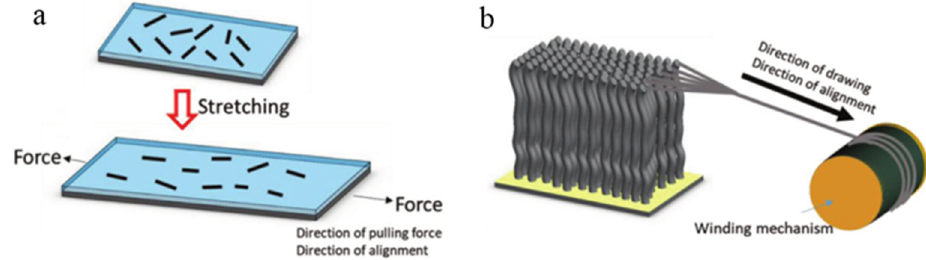
Figure 9. Aligning CNT by ( a ) film pulling method and ( b ) fiber drawing method. Reproduced with permission [43]. Copyright 2019, John Wiley and Sons.